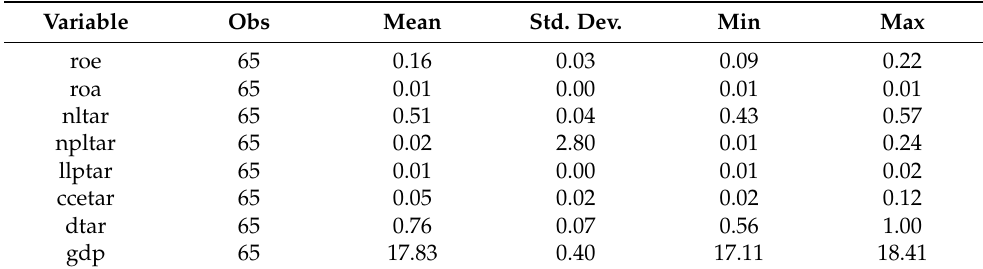
Table 2. Descriptive